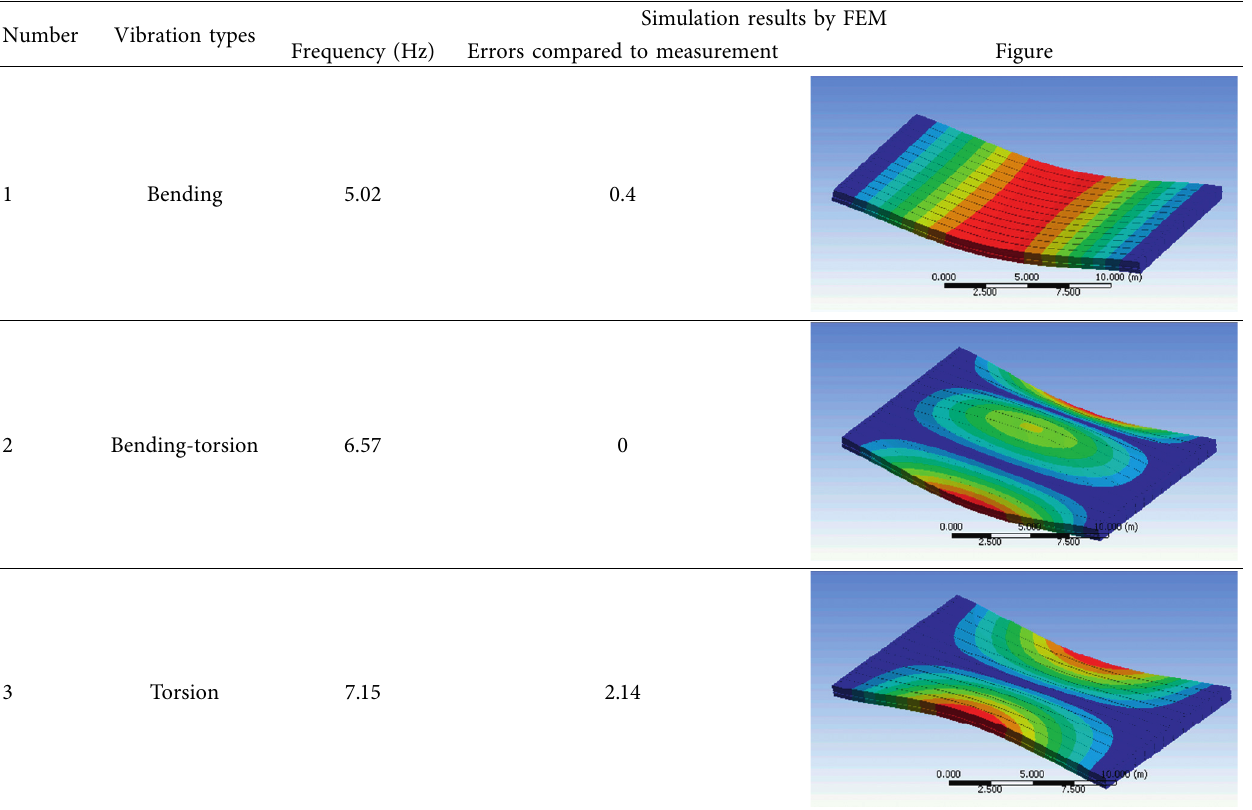
Table 4: The numerical simulation using finite element method at Ben Noc bridge.